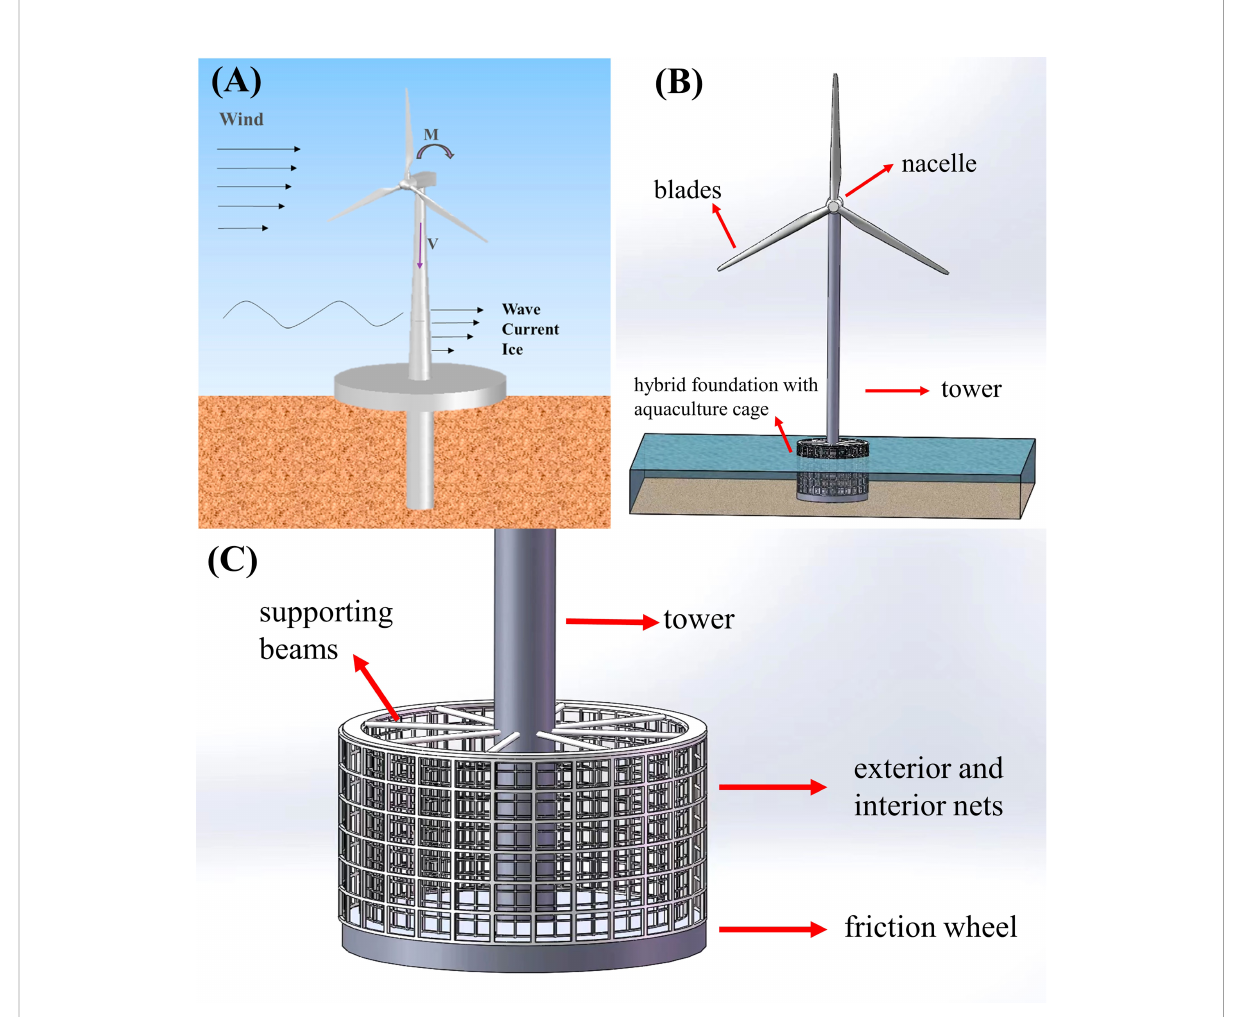
FIGURE 1 Hybrid monopile foundation for offshore wind turbine. (A) Hybrid monopile foundation with a friction wheel (Wang et al., 2018). (B) Hybrid monopile foundation with a double-layer aquaculture cage. (C) Details of the hybrid foundation with a double-layer aquaculture